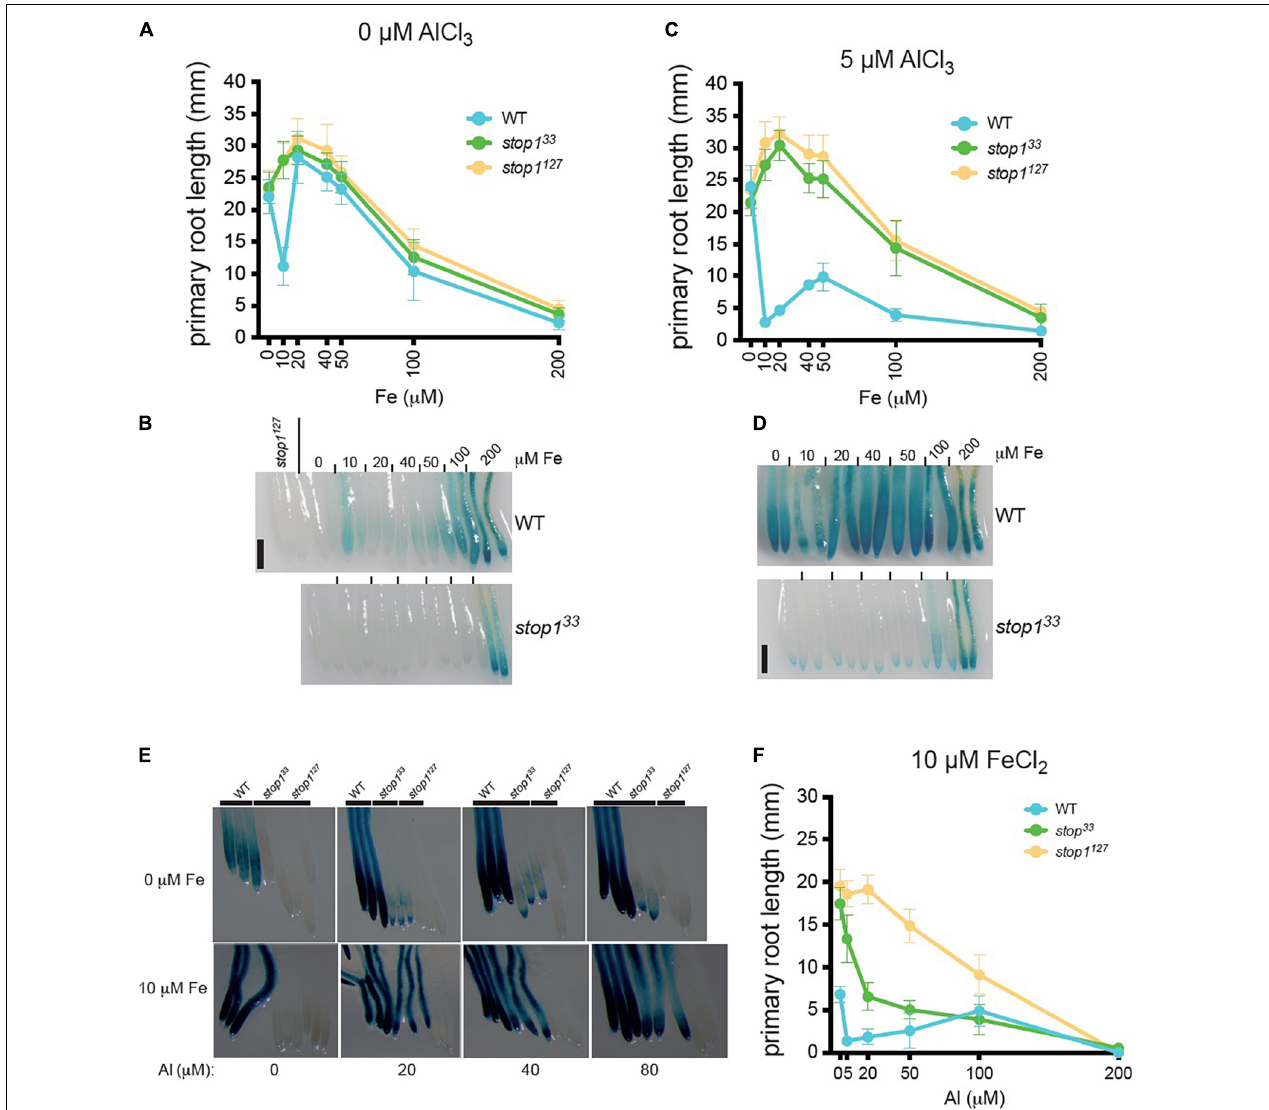
FIGURE 4 | ALMT1 expression is independently activated by iron (Fe) and Al but both mechanisms’ response can interact to enhance ALMT1 response in the root tip. (A) WT, stop1 33 and stop1 127 seedlings, carrying the pALMT1:GUS reporter, were grown 4 days on phosphate-rich medium (P 500 ) and transferred on a P 10 medium pH 5.7 at the indicated concentrations of FeCl 2 . After 3 days, the (cid:49) root growth of the primary roots was measured, and (B) seedlings were stained for GUS activity for 1 h. As a negative control of the GUS staining, the root tip of the two stop1 127 seedlings. Scales = 100 µ m. Mean ± SD ( n = 13–18 seedlings). (C) WT, stop1 33 , and stop1 127 seedlings, carrying the pALMT1:GUS reporter, were grown 4 days on a phosphate-rich medium and transferred on a P 10 medium with 5 µ M AlCl 3 at pH 5.7 at the indicated medium. After 3 days, the (cid:49) root growth of the primary roots was measured, and (D) seedlings were stained for GUS activity for 1 h. As a negative control of the GUS staining, the root tip of the two stop1 127 seedlings. Scales = 100 µ m. Mean ± SD ( n = 13–18 seedlings). (E) Four day-old WT, stop1 33 , and stop1 127 seedlings (carrying the pALMT1:GUS reporter) were grown 4 days on a P 500 Fe 10 medium and then transferred 3 days on low-phosphate (10 µ M KH 2 PO 4 ) at the indicated condition before the GUS staining for 2.5 h. Three representative root tips are shown per condition. (F) WT, stop1 33 , and stop1 127 seedlings were grown 4 days on a phosphate-rich medium and transferred on P 10 Fe 10 medium with the indicated concentrations of AlCl 3 , and the primary roots were measured. Mean ± SD ( n = 8–14